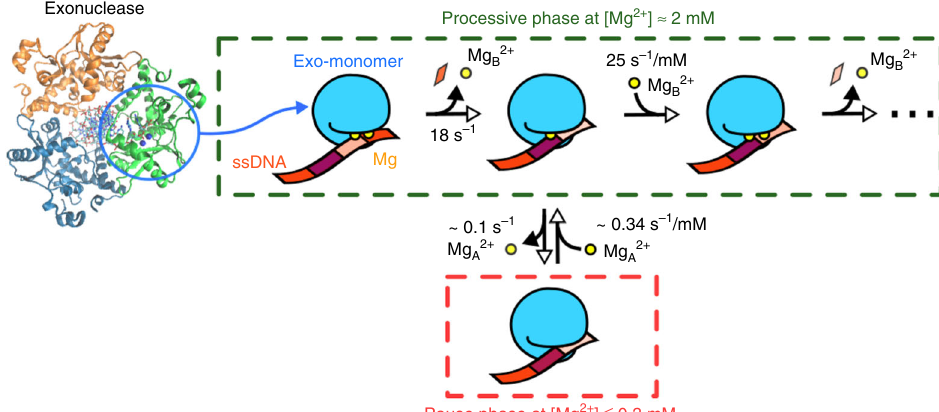
Fig. 6 The mechanism of two-metal-ion dynamics. The active site of one subunit of the homotrimer is shown in green whereas two Mg 2 + ions and nucleotides are represented by yellow circles and rectangles in various colors, respectively. Metal-ion coordination to the catalytic active site is highly dynamic so that two Mg 2 + ions (Mg A 2 + and Mg B 2 + ) can coordinate with and dissociate from the surrounding ligands. Mg A 2 + remains stably bound to the active site, but Mg B 2 + , which is close to the 5 ′ terminal side of the scissile phosphate, dissociates during every round of catalytic cleavage. As a result, the dissociation of Mg B 2 + facilitates product release and exonuclease translocation, promoting the overall processivity of exonuclease activity. More speci fi cally, at high [Mg 2 + ] ( ≈ 2 mM), λ -exonuclease degrades processively and its cleavage activity is mainly controlled by Mg B 2 + dynamics (green dashed square). The fast unbinding/rebinding dynamics of Mg B 2 + and strict requirement of two Mg 2 + ions for the catalytic step yield a Mg 2 + -concentration-dependent exonuclease activity. Conversely at low [Mg 2 + ] ( ≤ 0.3 mM), occasional unbinding of Mg A 2 + from the catalytic site and slow rebinding of Mg A 2 + stalls the exonuclease activity, giving rise to a long pause (red dashed square), thus elucidating the molecular origin of dynamic heterogeneity in exonuclease activity. The dynamic variation in the coordination states of two metal ions orchestrates the multistep process of exonuclease